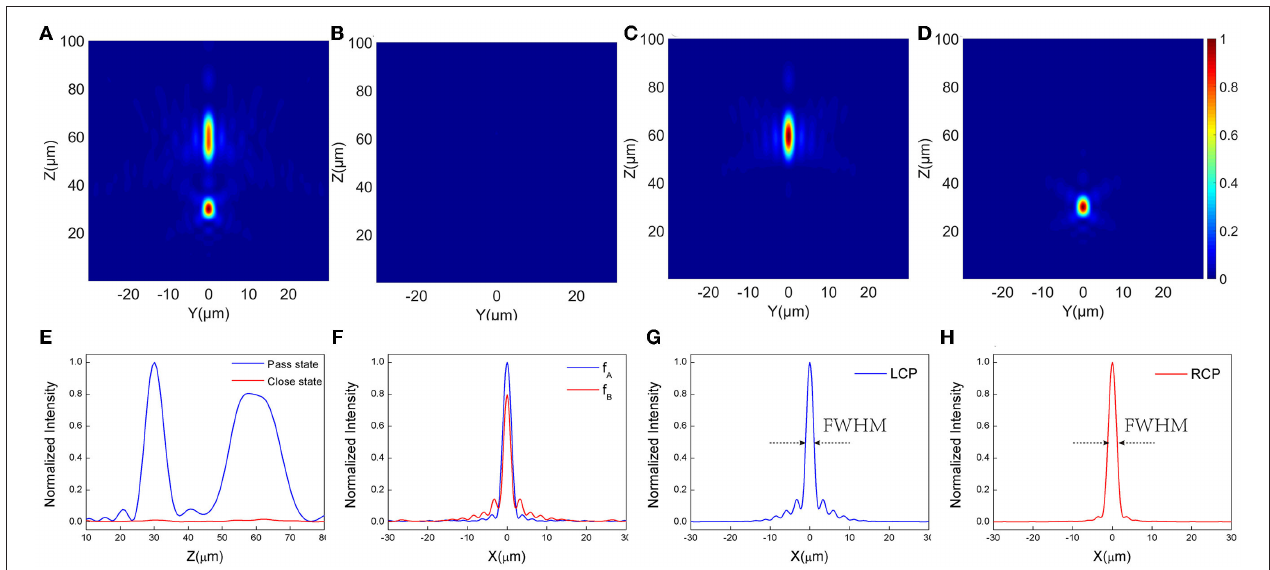
FIGURE 5 | (A–D) The intensity profiles(y-z plane)of the metalens designed at the state of (A) for x-polarized incident light in the pass state, (B) for x-polarized incident light in the close state, (C) for LCP polarization incidence in the B pass state, (D) for RCP polarization incidence in the A pass state, (E) Normalized electric field intensity distribution along the z-axis for the two cases (A,B) . (F) Corresponding to the horizontal cut of the two focal points f A and f B in (A) , the width FWHM at half the maximum height is 2.53 µ m and 2.15 µ m. (G,H) represent the normalized electric field intensity graph under the incidence of LCP and RCP, respectively, and the corresponding FWHMs are 2.17 µ m and 2.39 µ m, respectively.